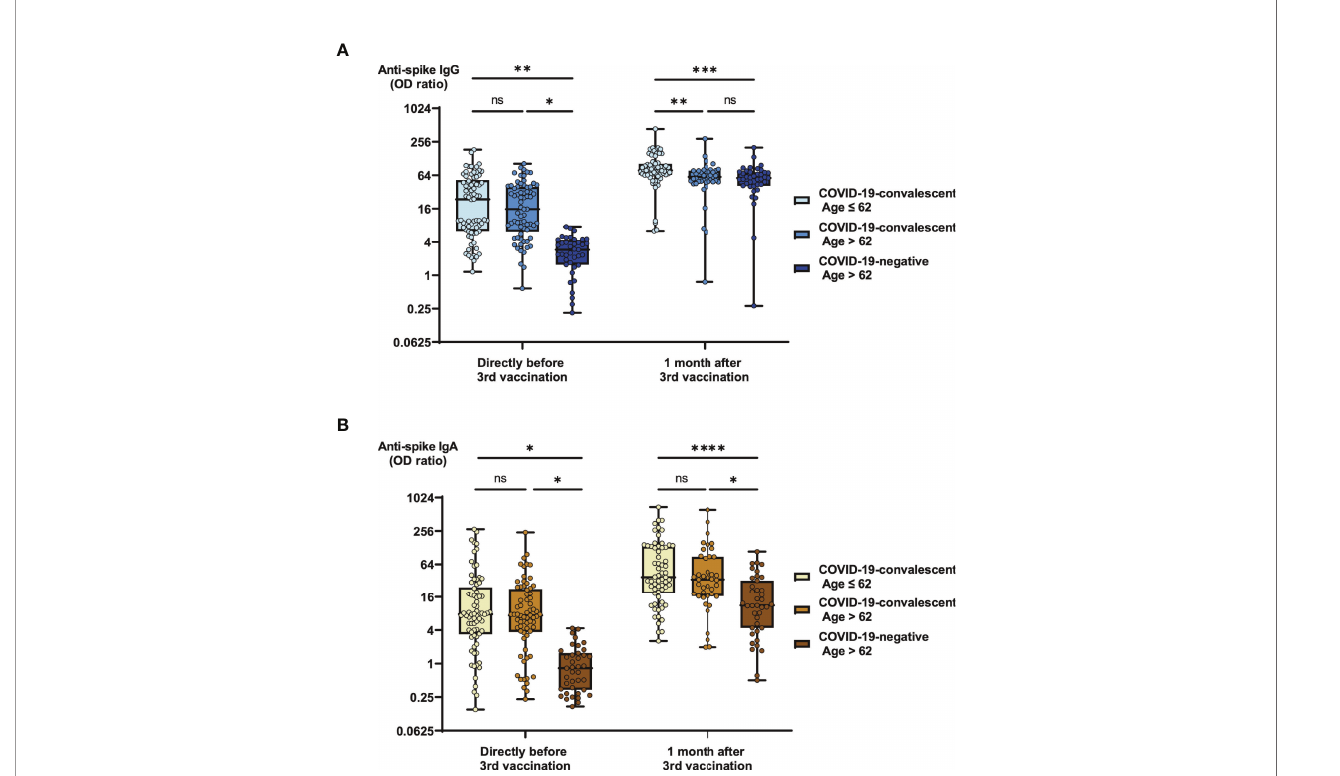
FIGURE 3 | Impact of age and previous SARS-CoV-2 infection on SARS-CoV-2-speci fi c antibody responses before and after booster vaccination. Serum samples from 73 COVID-19-convalescent individuals under the age of 63, 74 COVID-19-convalescent individuals above the age of 62 and 39 individuals above the age of 62, who never had a SARS-CoV-2 infection were collected directly before and one month after booster vaccination with BNT162b2. Samples were then analyzed for anti-spike IgG and IgA titers. Box blots show (A) anti-spike IgG titers and (B) anti-spike IgA titers before and after vaccination as indicated. Box central horizontal lines indicate medians, box borders represent IQR, whiskers indicate minima and maxima. Signi fi cance levels were *p < 0.05, **p < 0.005, ***p < 0.0005 and ****p < 0.00005. IQR, interquartile ranges, ns, not signi fi cant; OD, optical